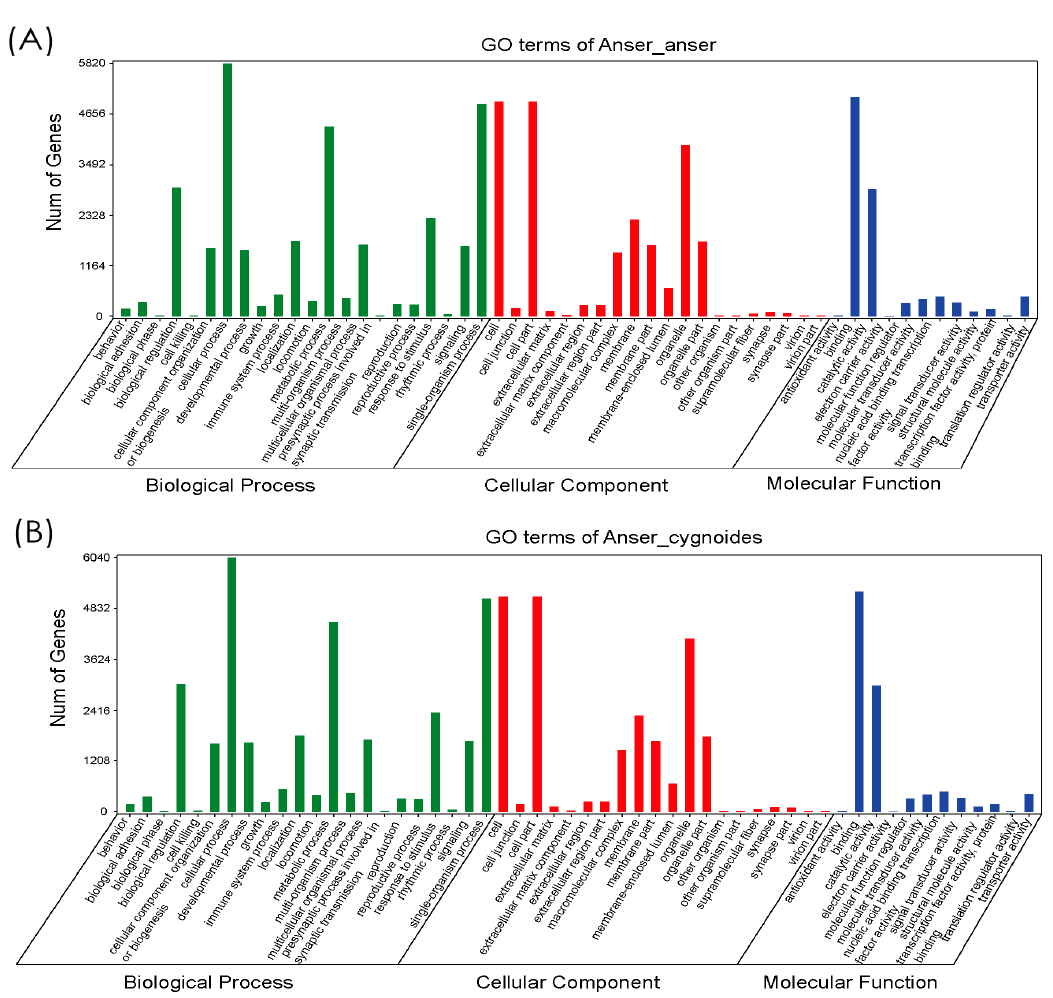
Figure 3. Comparison of the GO functional annotations of unigenes between the Anser anser ( A ) and Anser cygnoides ( B ) species into three major categories: biological process, cellular component, and molecular function.